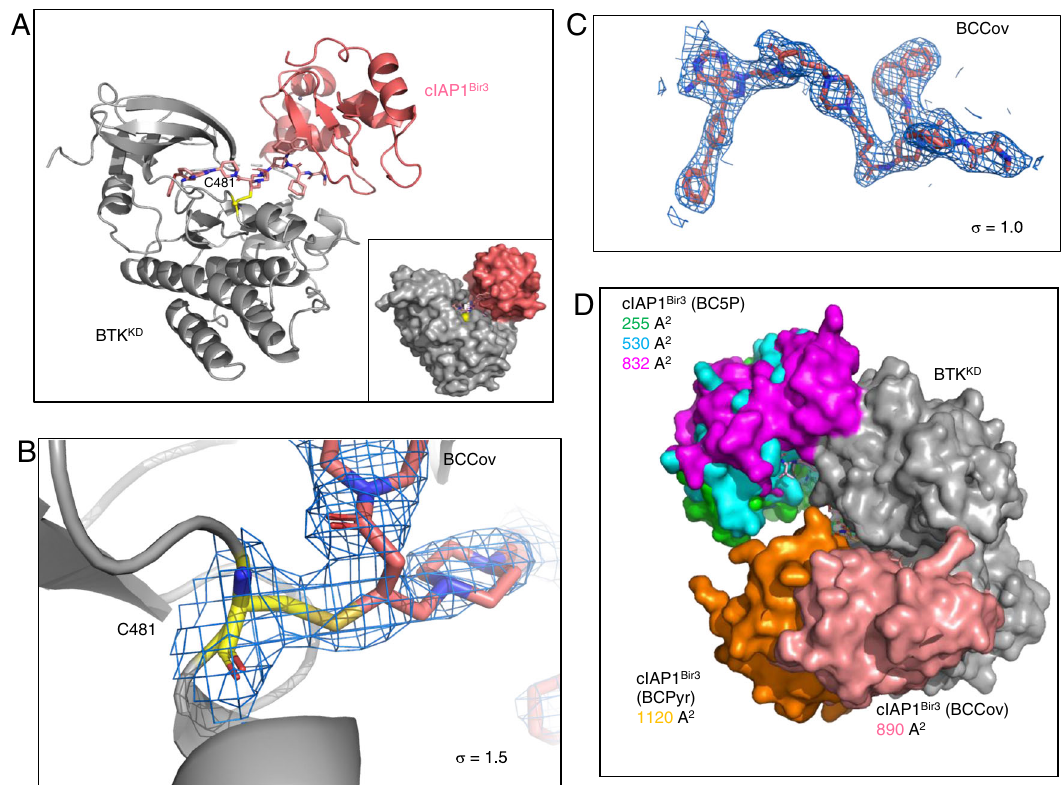
Fig. 4 | Ternary complex crystal structure of BTK KD ~BCCov-cIAP1 Bir3 . A Cartoon depiction of BTK KD (gray), BCCov (elemental/pink), cIAP1 Bir3 (salmon), cysteine 481 backbonehighlightedinyellow,andasurfacemodel(inlay). B Cysteine481(yellow) shows continuous electron density to BCCov at stringent 2Fo-Fc density ( σ =1.5). C Electron density at2Fo-Fc density ( σ =1.0)surrounding BCCov. D Surface model